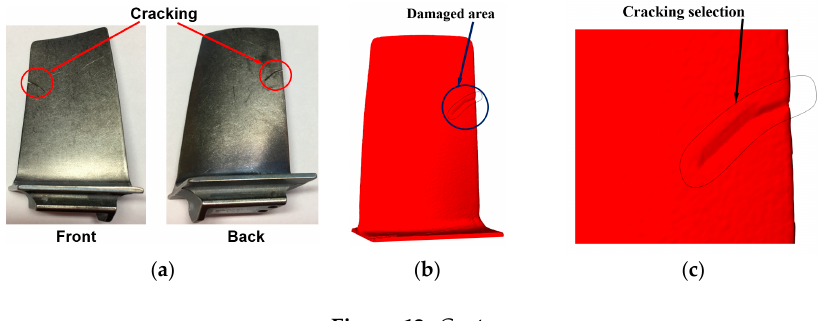
Figure 11. ( a ) A die with surface superficial defects; ( b ) STL model of the die; ( c ) machining toolpath; ( d ) model of the die after